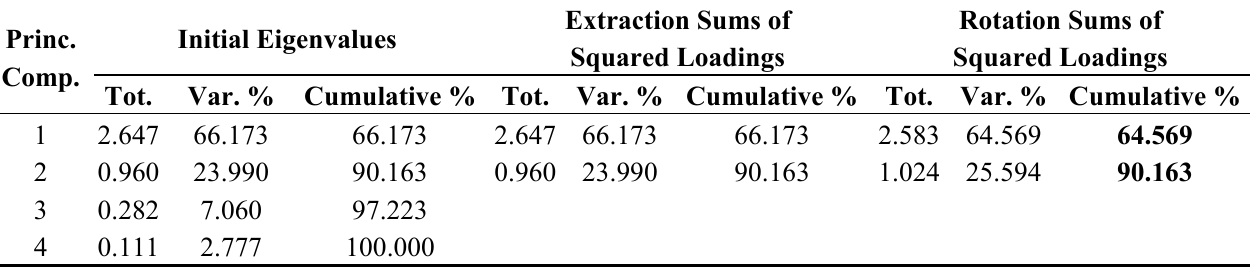
Table 3. Total variance of two principal components extracted from four meteorological variables. Princ.